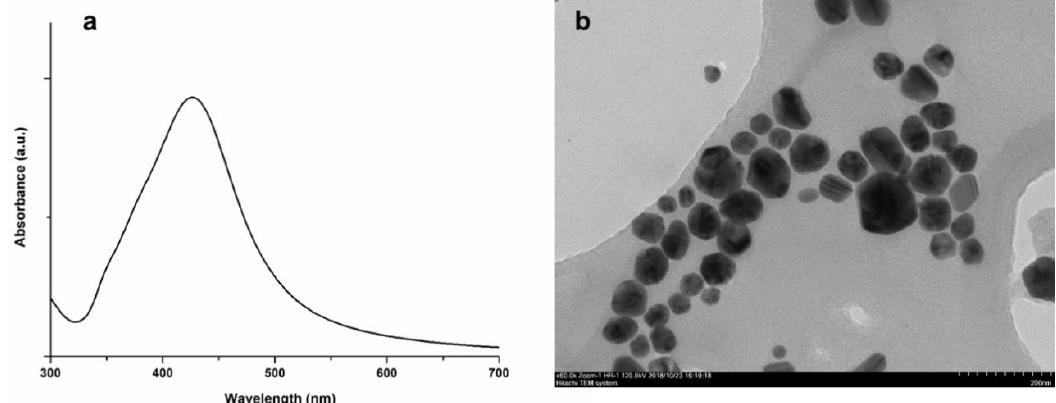
Figure 1. Representative SEM images of GNAs ( a and b ) and GNA@PDOP ( c and d ) at different magnifications. For the case of GNA@PDOP, PDOP deposition time was 30 min.